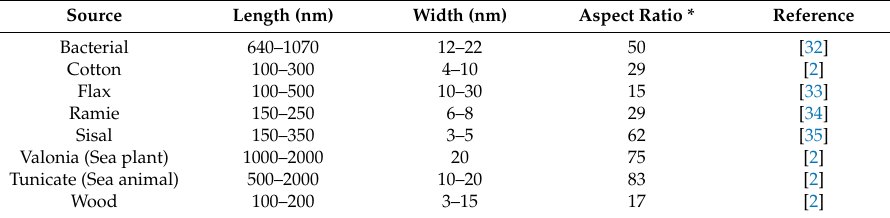
Table 1. Aspect Ratio of cellulose nanocrystals (CNC) Derived from Different